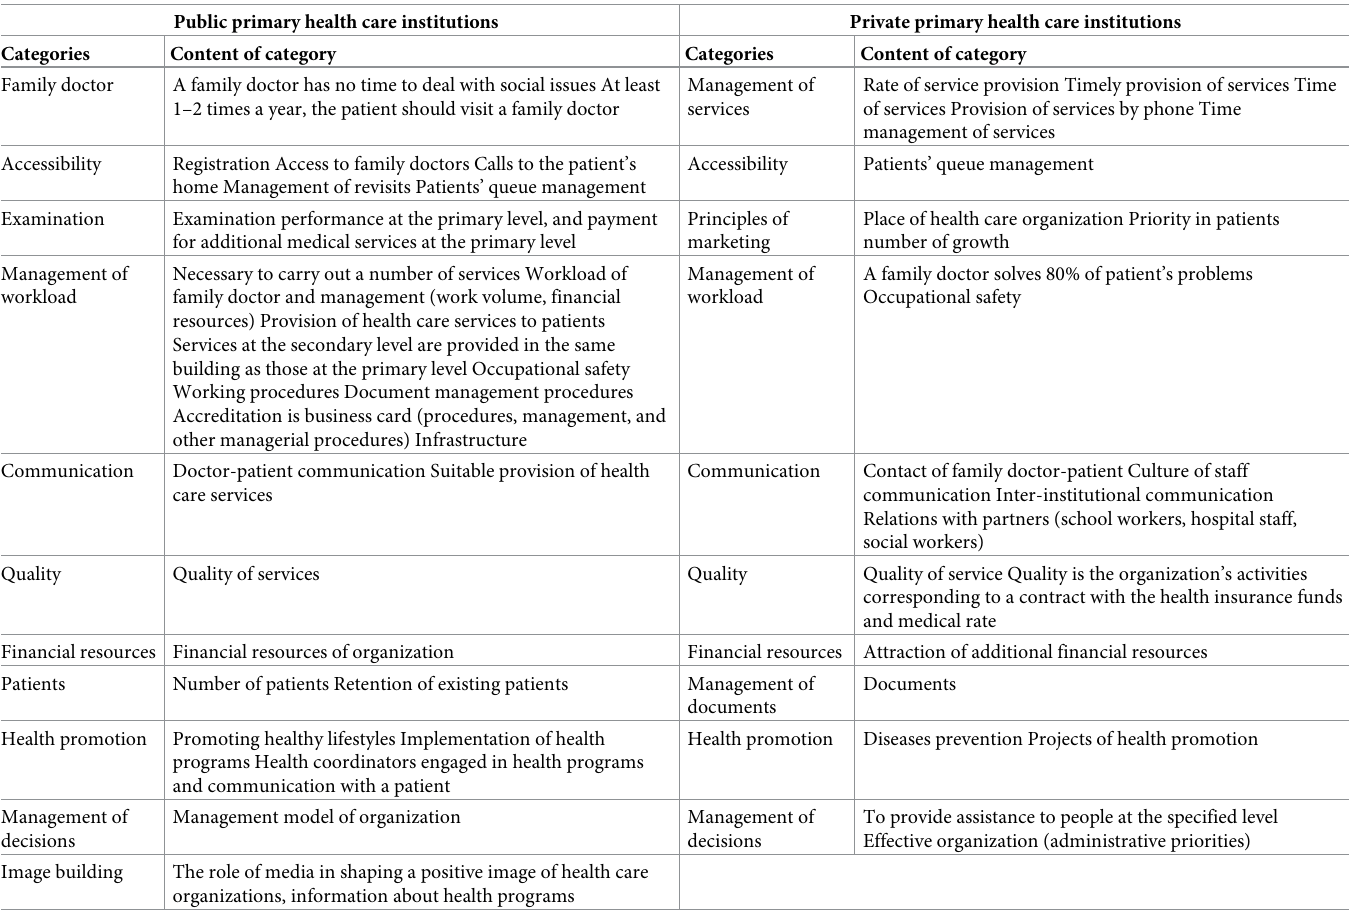
Table 2. Categories of “management of organization”